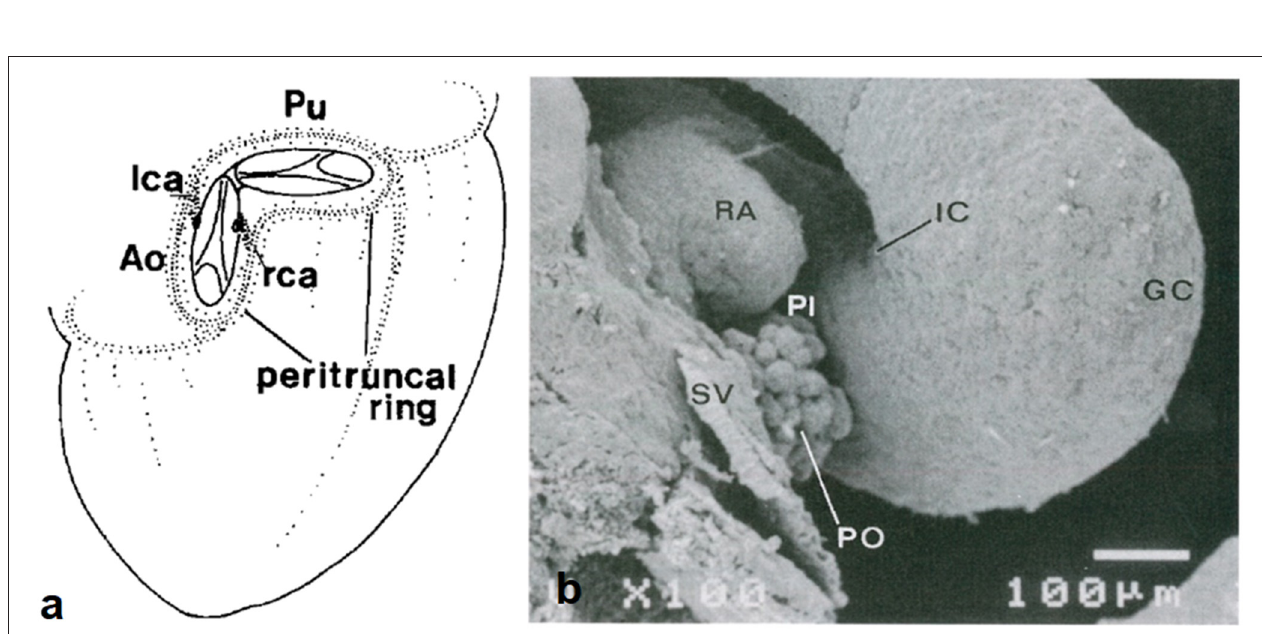
FIGURE 13 | Origin of coronary arterial stems from the peritruncal epicardial ring. (a) From Bogers et al. (17). (b) From de la Cruz et al. (13).